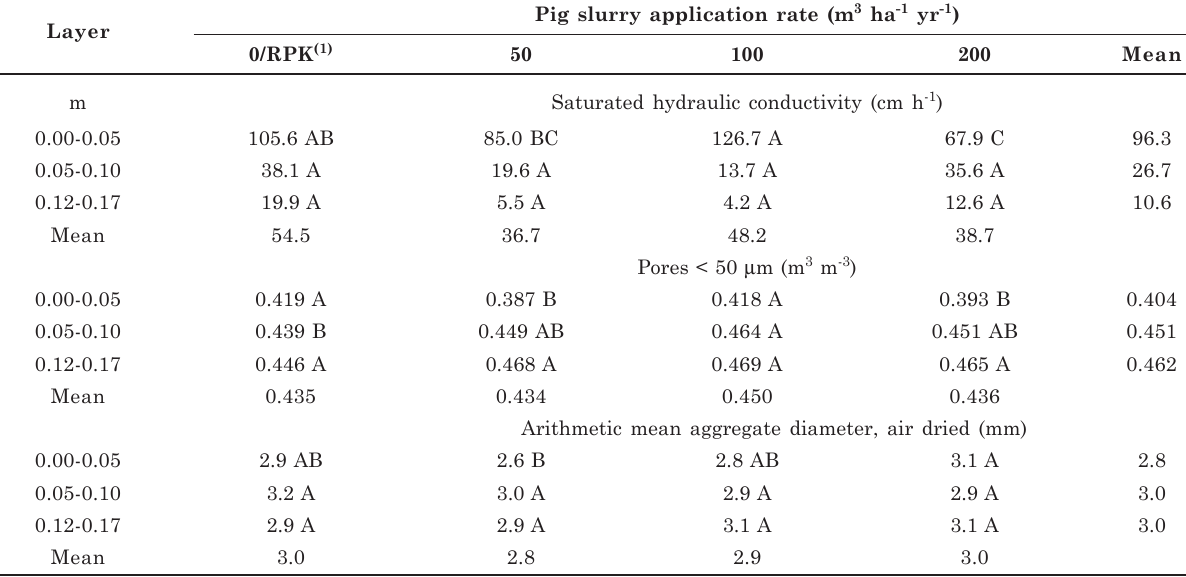
Table 3. Physical properties of an Hapludox after 12 years of pig slurry applications that showed differences among application